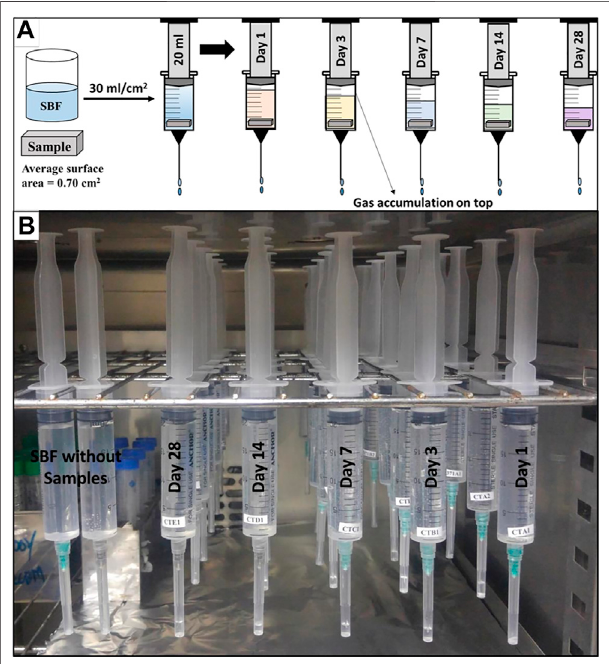
FIGURE 1 | (A) Drawing of the immersion test assembly (B) Immersion test setup in